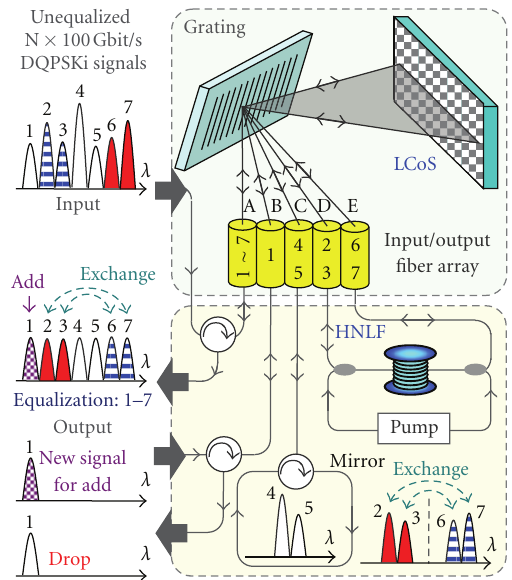
Figure 25: Concept and principle of LCoS+HNLF-based mul- tifunctional grooming switch (add/drop, data exchange, power